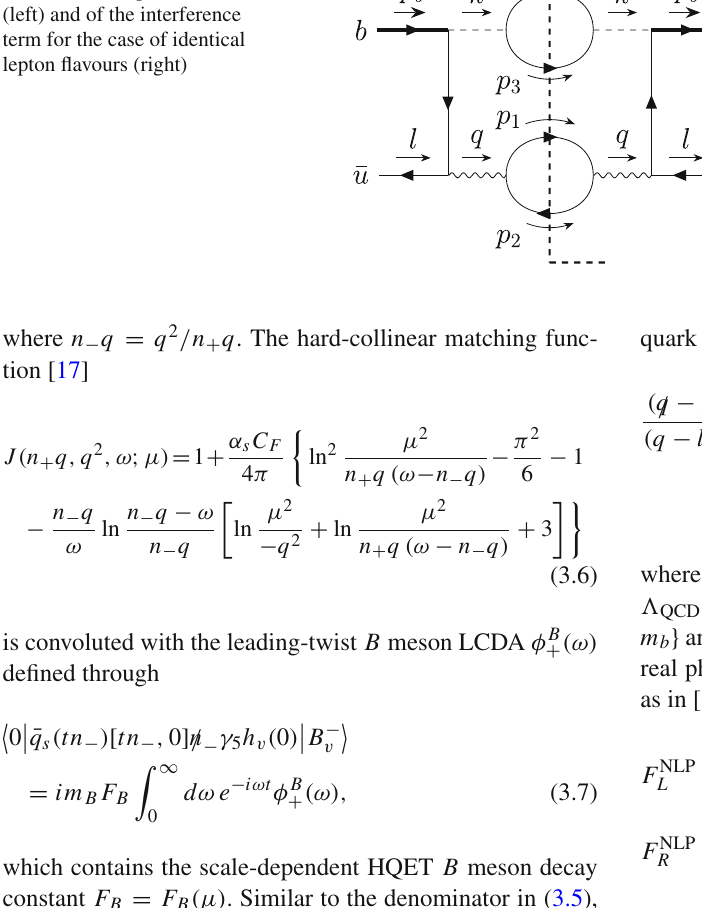
Fig. 1 Graphical representation of the squared amplitude for the non-identical-lepton final-state (left) and of the interference term for the case of identical lepton flavours